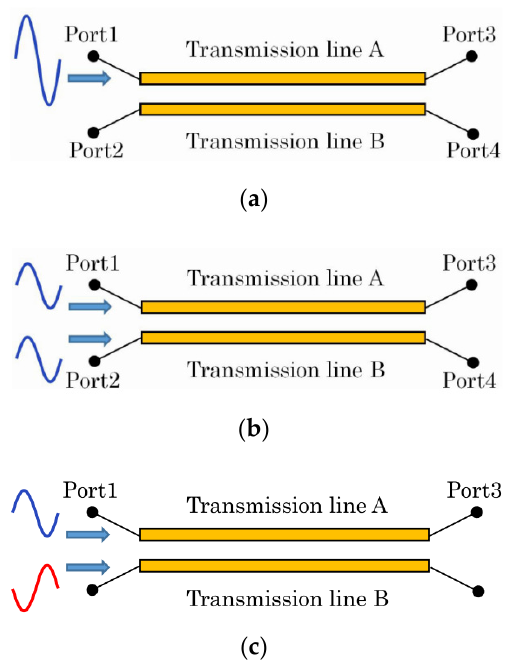
Figure 5. A coupler composed of two transmission lines. ( a ) Geometry and Port 1 excitation. ( b ) Port 1 and Port 2 excitation with the in–phase signals (even mode). ( c ) Port 1 and Port 2 excitation with the anti–phase signals (odd